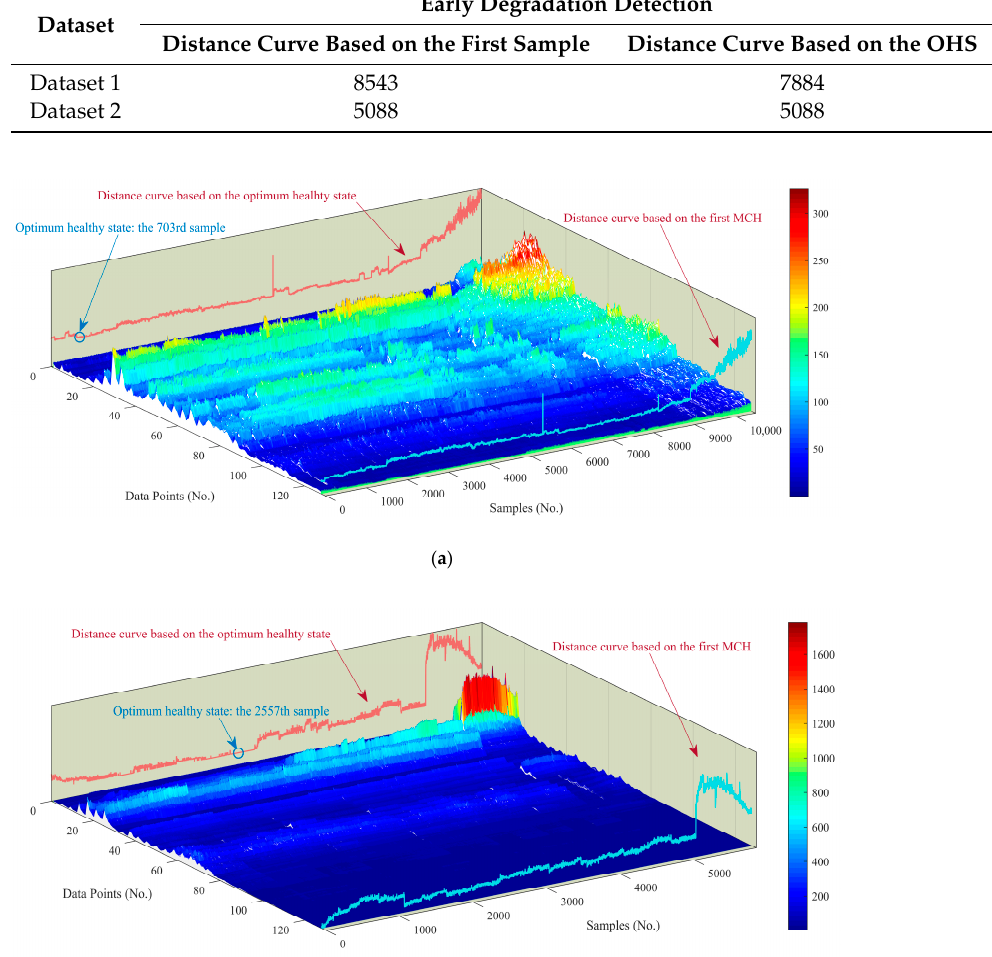
Figure 16. Distance curves calculated based on the first MCH: ( a ) Dataset 1, ( c ) Dataset 2; distance curves calculated based on the OHS: ( b ) Dataset 1, ( d ) Dataset 2. Table 9. Quantitative comparison of early degradation detection results. Dataset